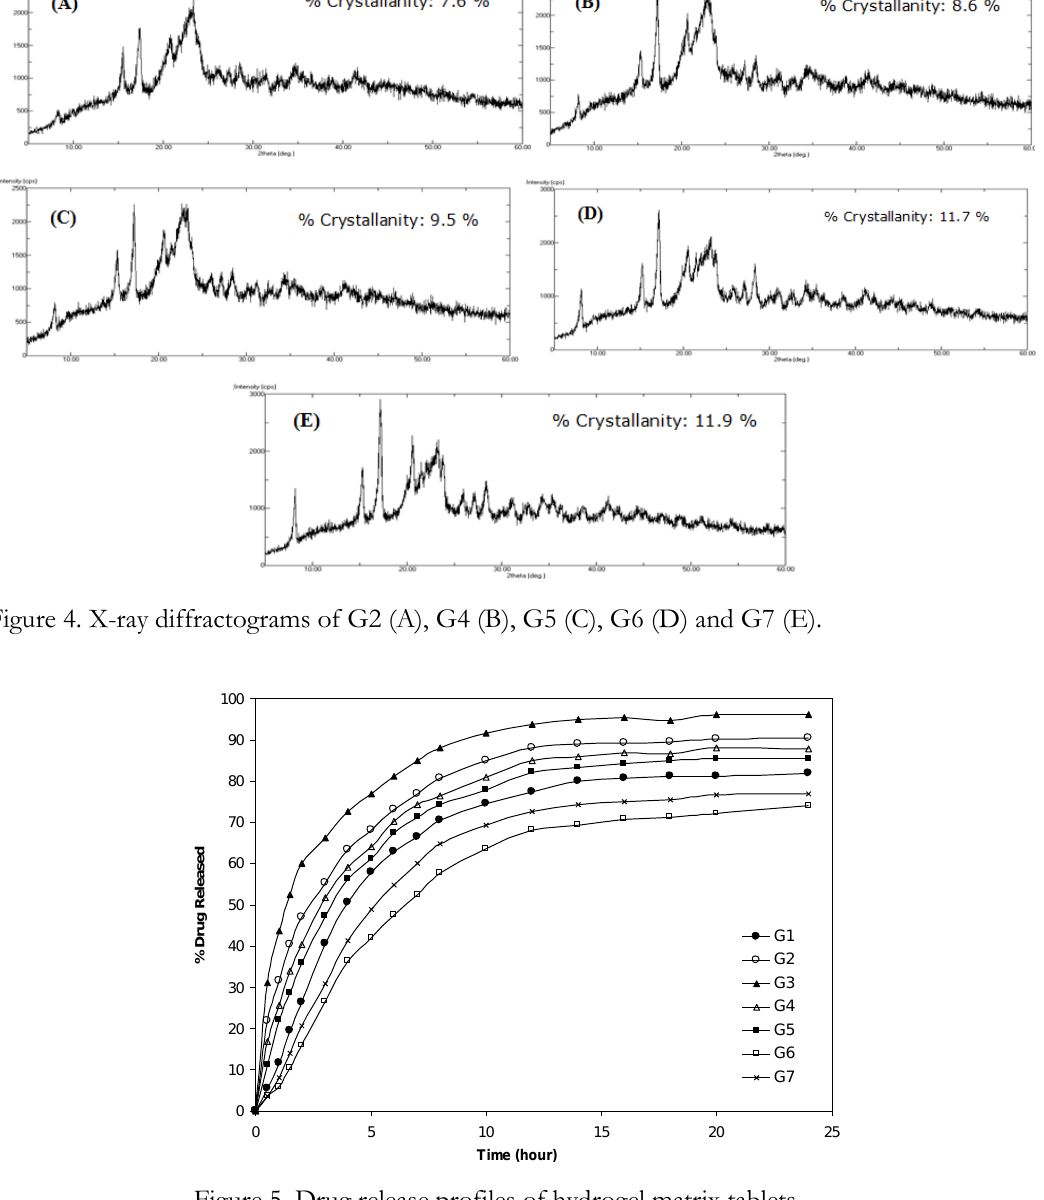
Figure 5. Drug release profiles of hydrogel matrix